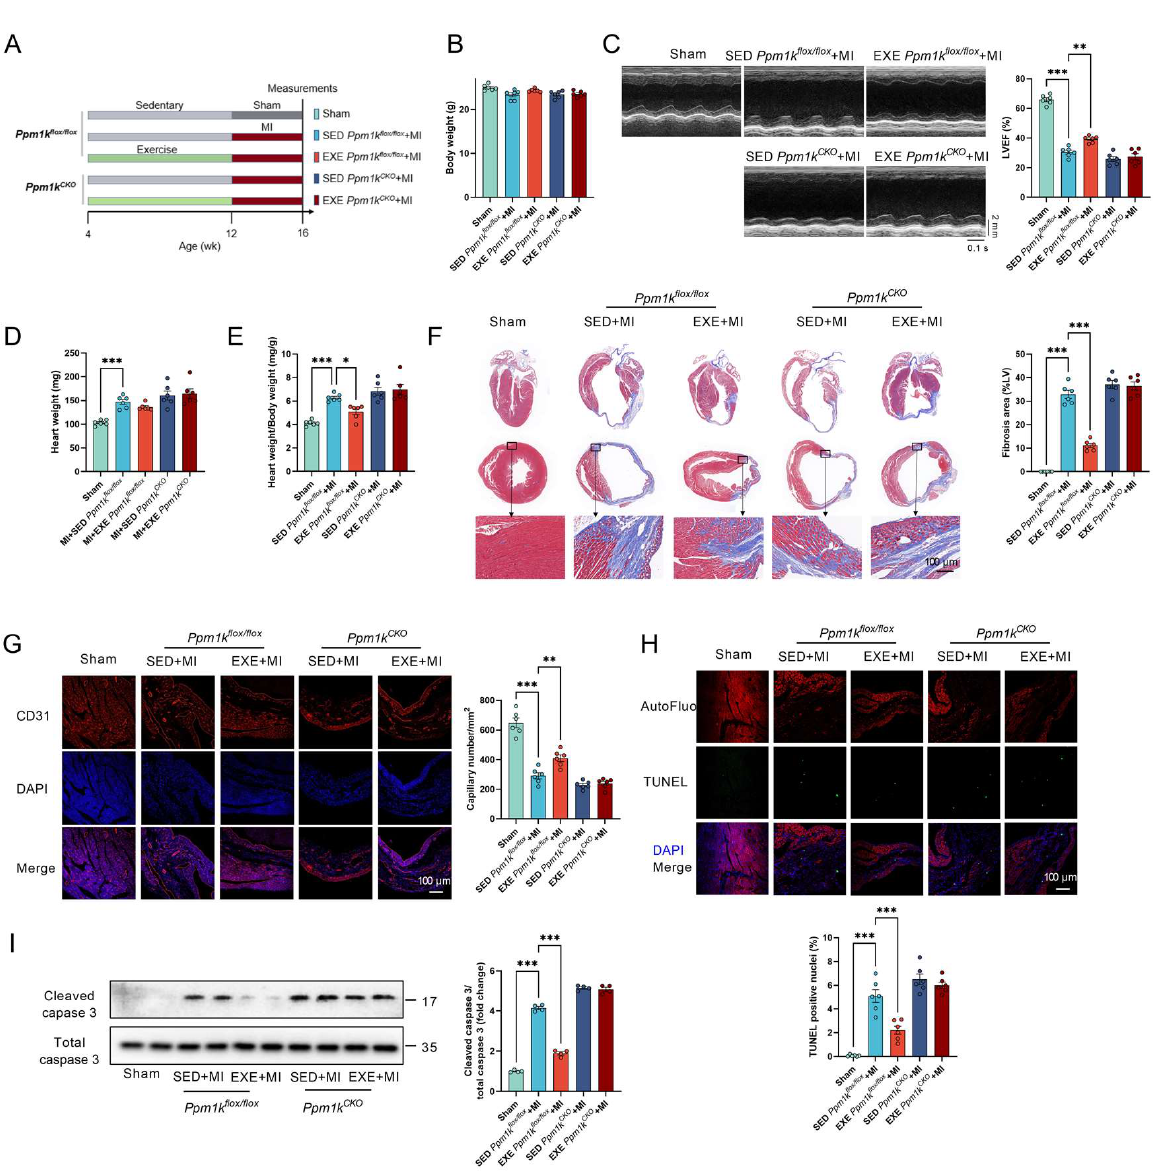
Figure 5. Cardiac-specific PP2Cm KO abolished the cardioprotective effects of exercise. ( A ). The control ( Ppm1k flox/flox ) and KO ( Ppm1k CKO ) mice were subjected to MI after an 8-week exercise intervention